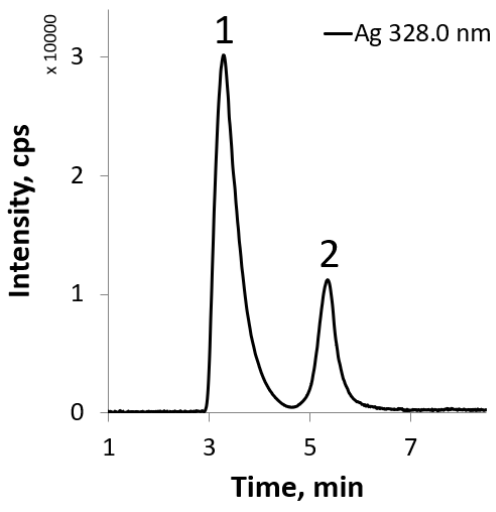
Figure 3. The HPLC-ICP-AES chromatogram of the solution of 1 in coordinates “retention time– line intensity”.